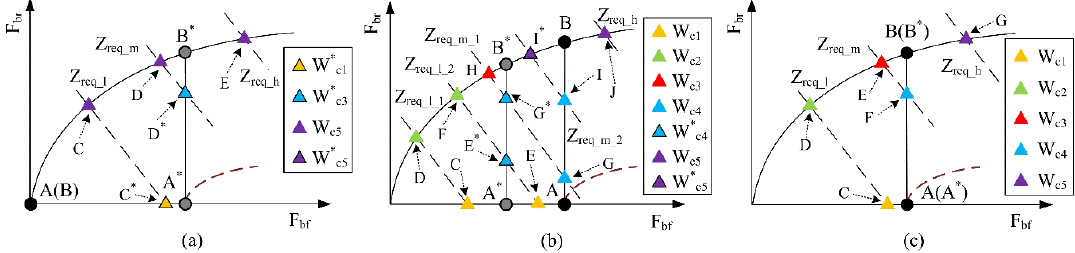
Figure 12. Change of the work-point before and after optimization: ( a ) μ max _ l = 0.3; ( b ) μ max _ m = 0.6; and ( c ) μ max _ h = 0.9.